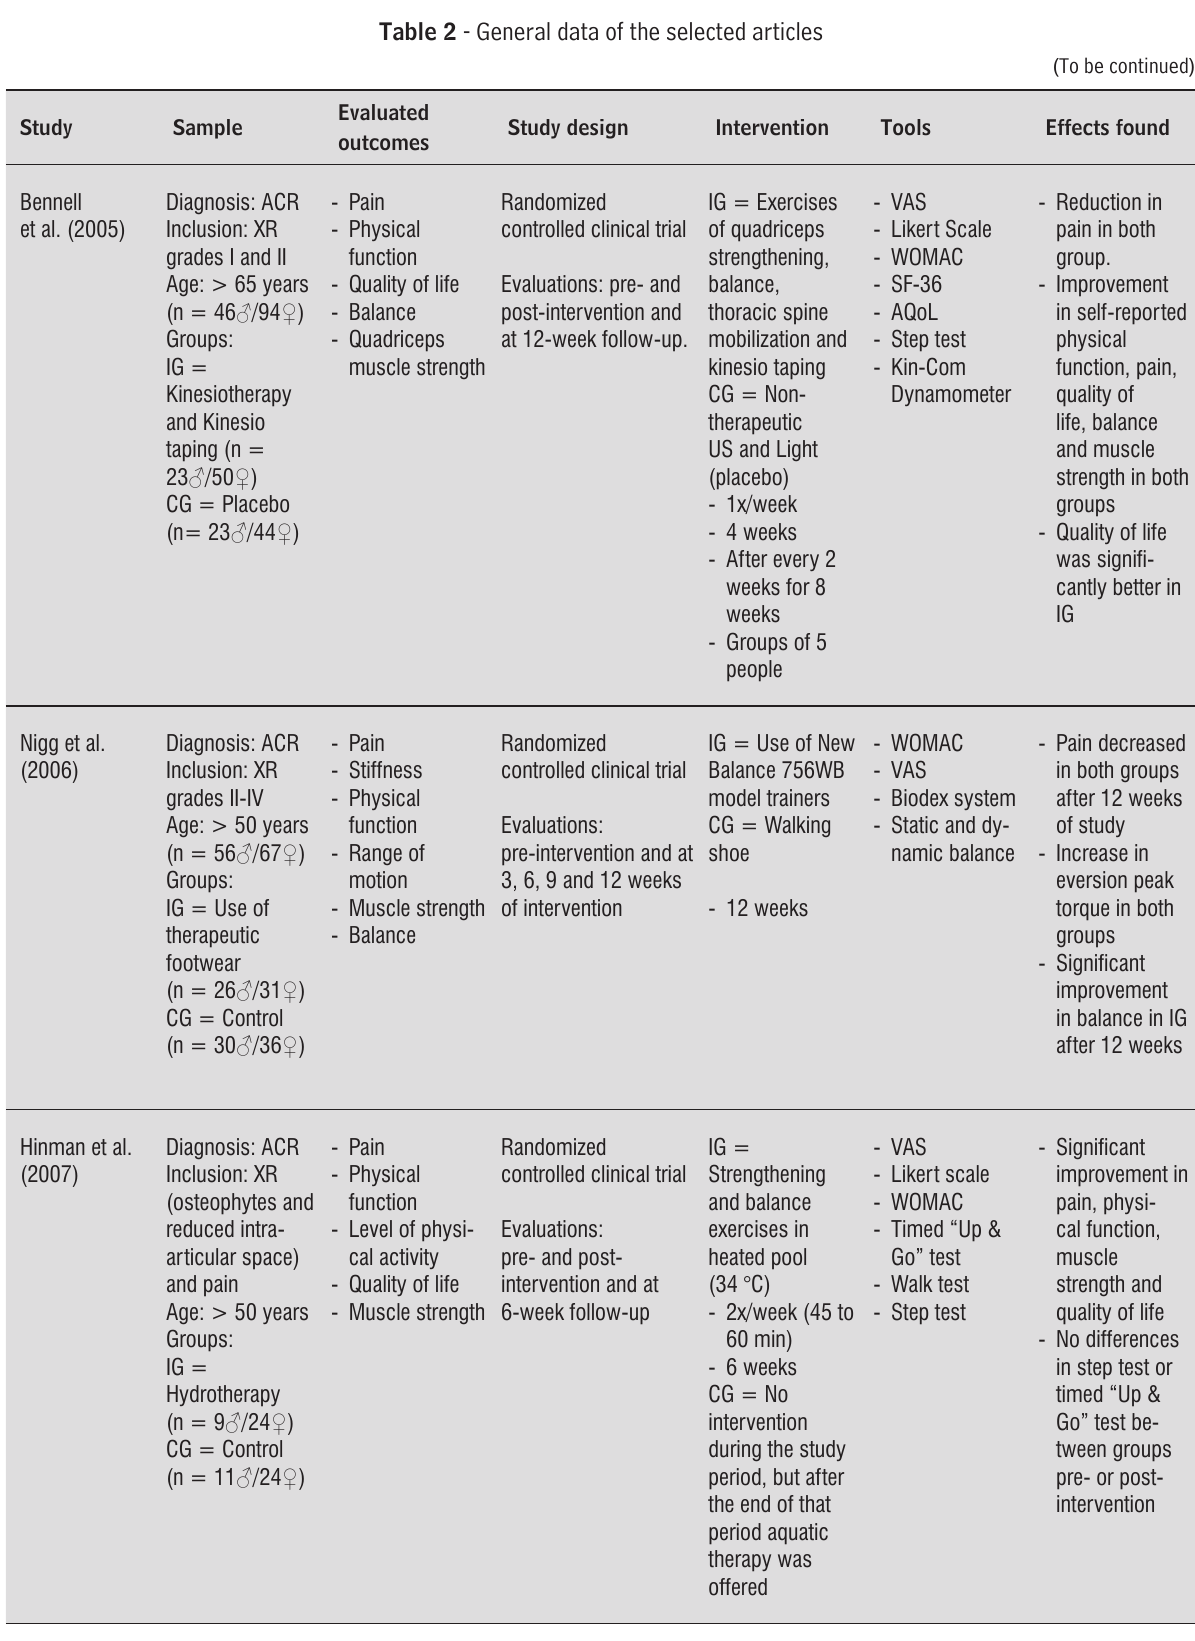
Table 2 - General data of the selected